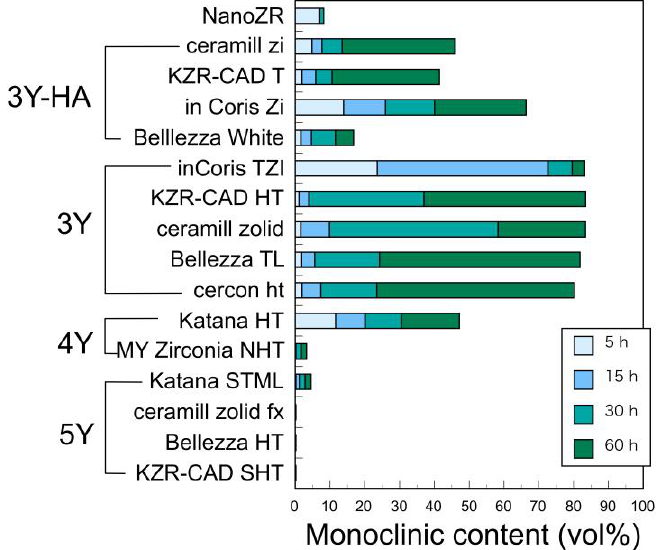
Figure 18. Monoclinic content of dental zirconia after storage in autoclave at 134 °C for 5–60 h. Adopted from Ref. [44].